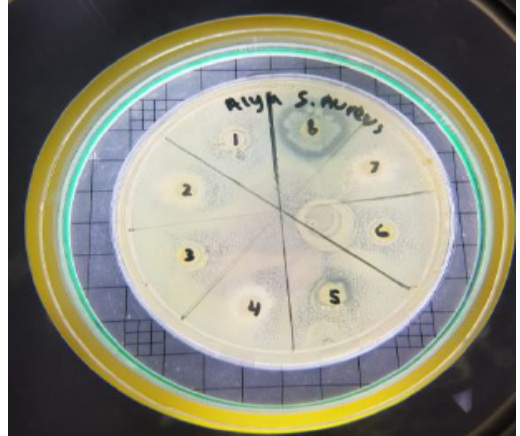
Figure 7. Antibacterial activity of CS-Tb 2 S 3 NCs with variable concentrations: (1) 0.2 mg/mL; (4) 0.3 mg/mL; (7) 0.5 mg/mL. Other numbers (2, 3, 5, and 6) correspond to other metal-based nanoparticle systems (CdS, Ag 2 S, Eu 2 S 3 , ZnS) for comparative purposes. Tetracycline is the positive control (8).